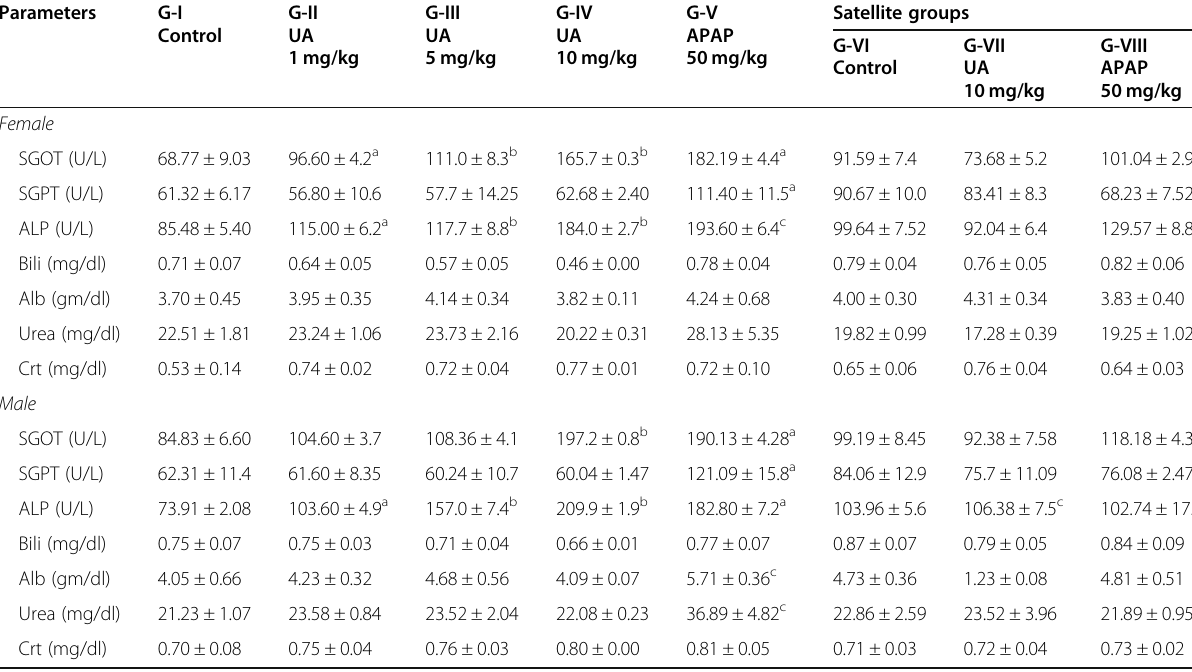
Table 6 Effects of sub-acute oral administration of UA and APAP on selected biochemical parameters of Wistar rats ( n =